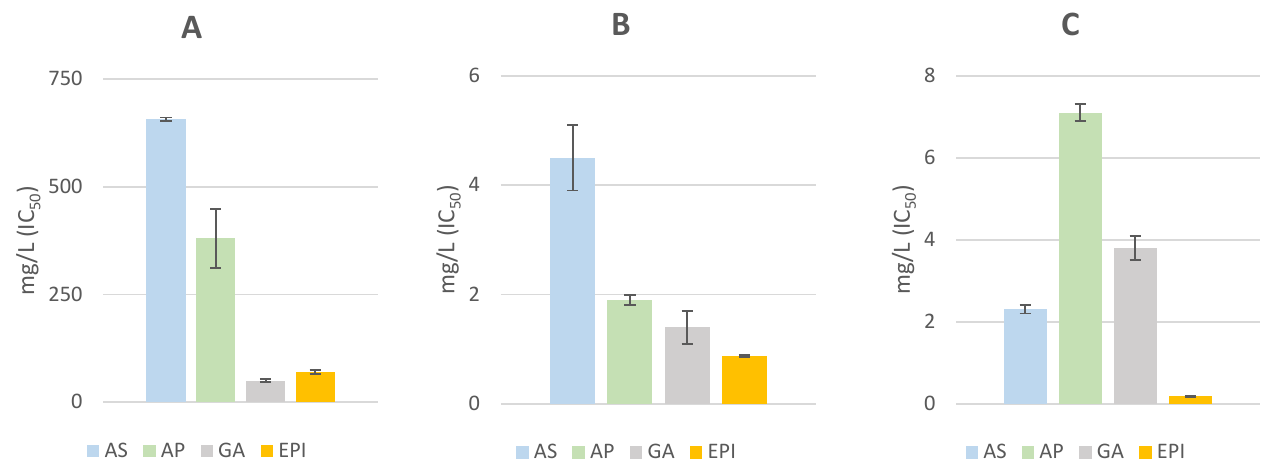
Figure 2. Radical scavenging assessment of ( A ) · O 2 , ( B ) · NO and ( C ) HOCl by avocado seed (AS) and peel (AP). Results are expressed as the concentration in mg/L needed to inhibit the response by 50% (IC 50 ). Data are means ± standard deviation (n = 3) Positive controls used were GA, gallic acid, and EPI,